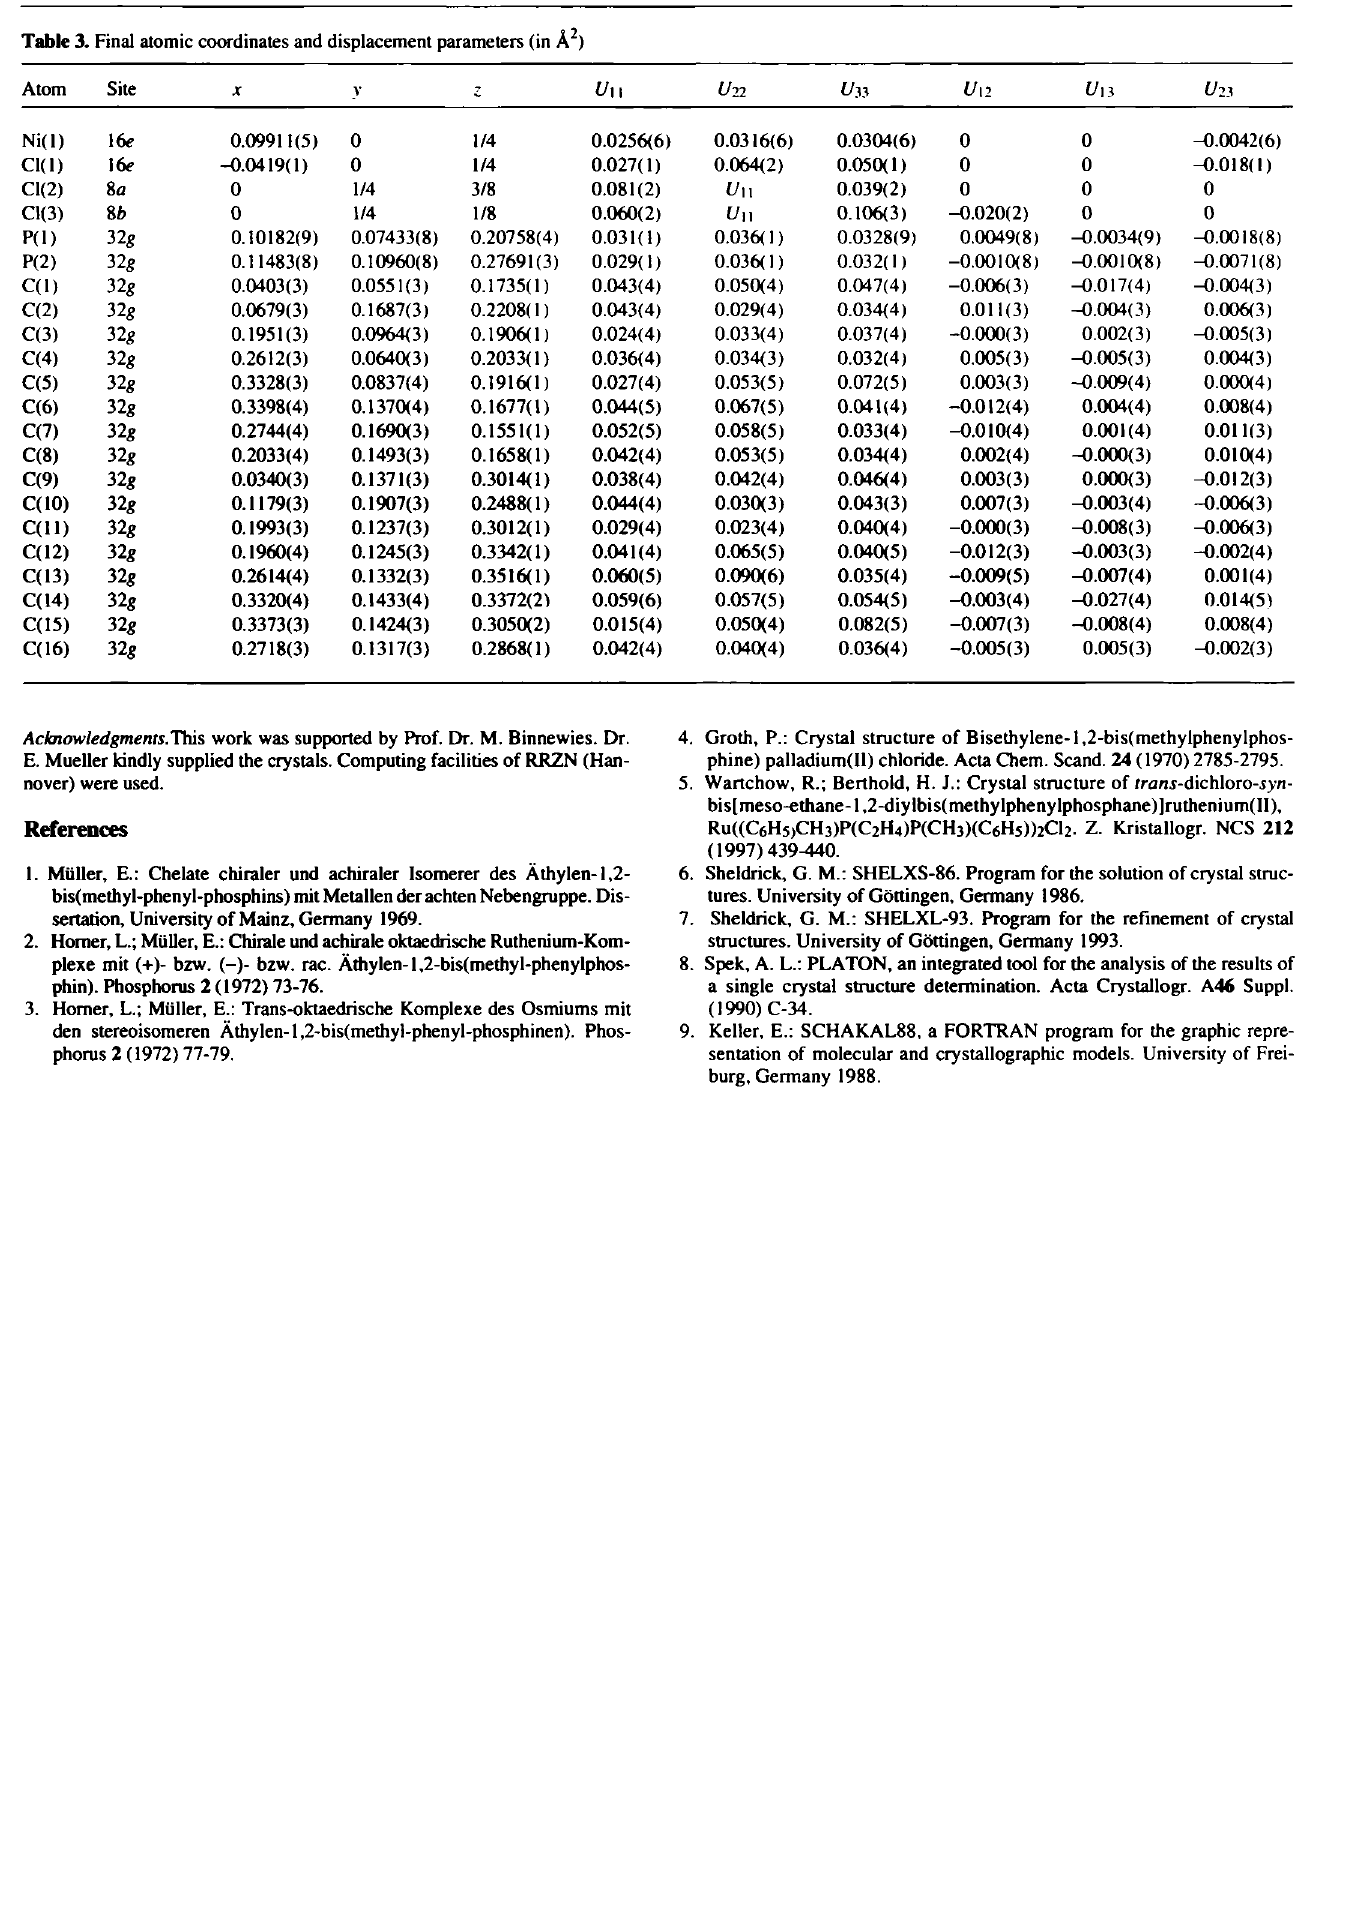
Table 3. Final atomic coordinates and displacement parameters (in Â^) Atom